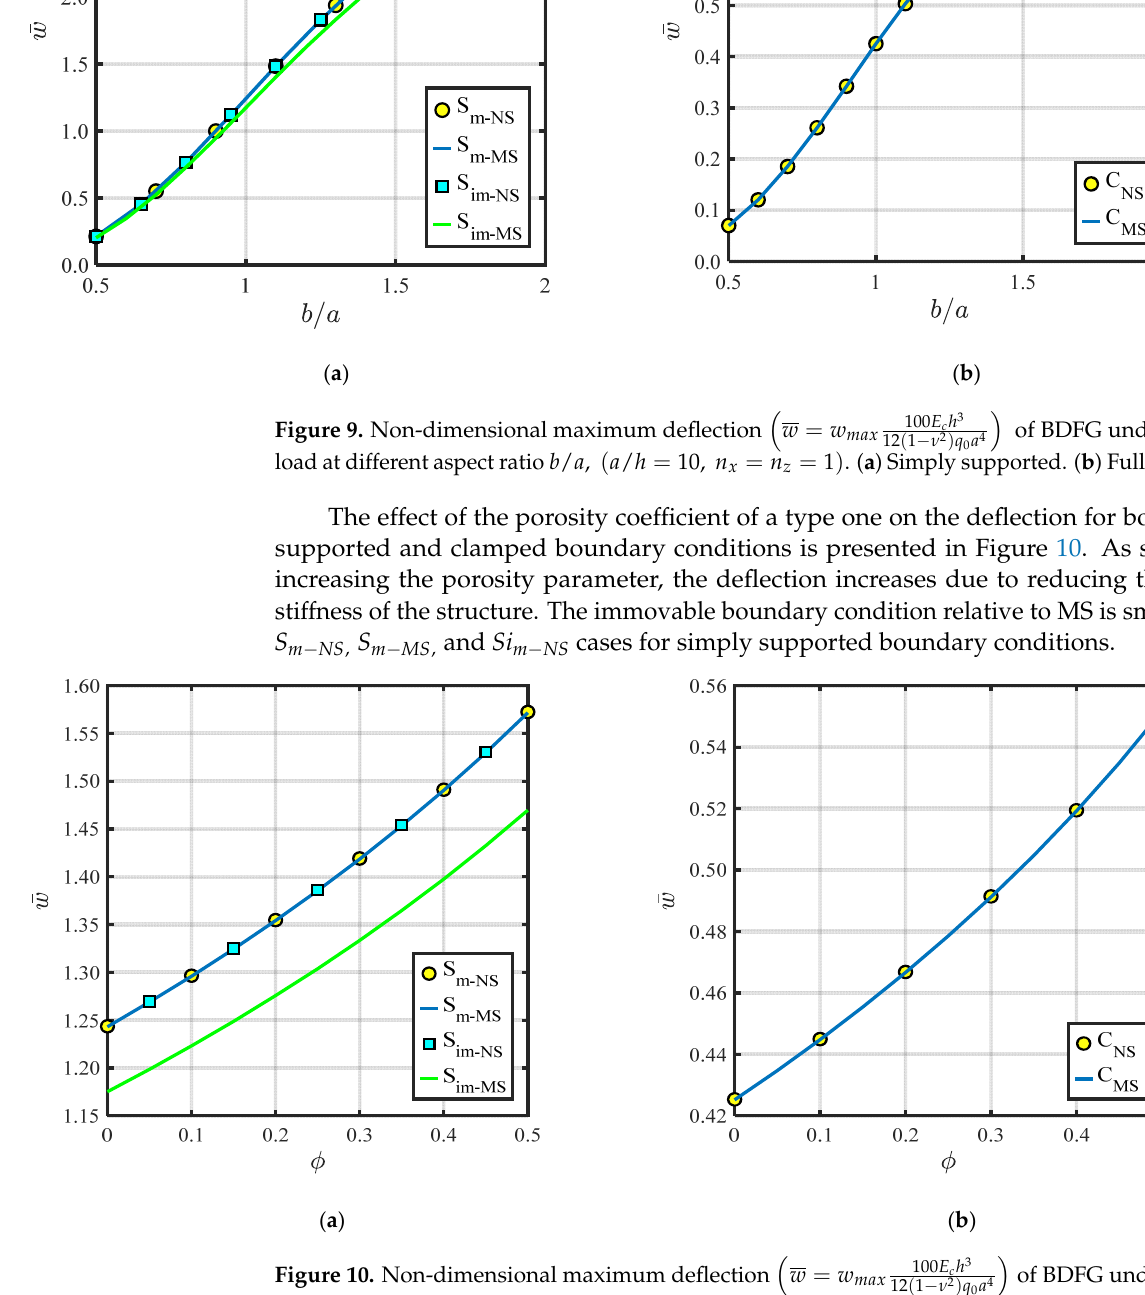
Figure 10. Non-dimensional maximum deflection (cid:4672)𝑤(cid:3365) = 𝑤 (cid:3040)(cid:3028)(cid:3051) (cid:2869)(cid:2868)(cid:2868)(cid:3006) (cid:3278) (cid:3035) load at a different porosity parameter 𝜙 (type 1), (𝑎 ℎ⁄ = 10, 𝑛 (cid:3051) = 𝑛 (cid:3053) = 1) . ( a ) Simply Supported. ( b ) Fully clamped.